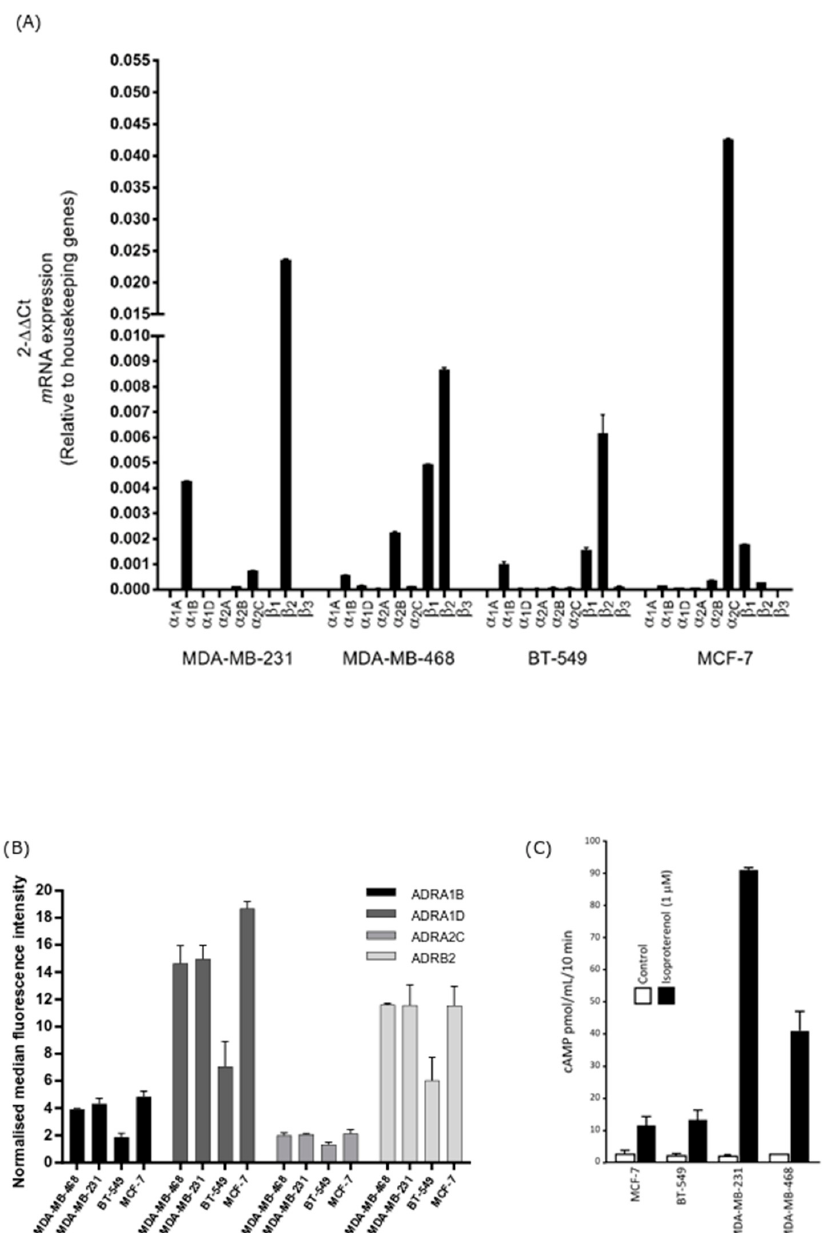
Figure 1. Adrenoceptor (ADR) expression on breast cancer cells and measurement of cAMP (cyclic adenosine monophosphate) levels following adrenergic stimulation. ( A ) Relative expression of ADR mRNA in breast cancer cell lines was quantified by qRT-PCR (quantitative reverse transcription polymerase chain reaction) and relative expression (2 −ΔΔ CT ) was determined by normalisation to housekeeping genes. β 2-adrenoceptor gene expression was strongest in the basal-type cell lines MDA-MB-231 and MDA-MB-468. ( B ) Expression of the adrenoceptors on unpermeabilised breast cancer cells was assessed by measuring median fluorescence intensity (MFI) using flow cytometry. Membranous β 2-adrenoceptor protein expression was highest in the basal-type cell line MDA-MB-468, followed by MDA-MB-231 > MCF-7 > BT-549. ( C ) Isoproterenol ( β -agonist) stimulated cAMP accumulation in breast cancer cell lines. Cells were treated in the presence of IBMX to prevent cAMP degradation. cAMP production was highest in the order MDA-MB-231 > MDA-MB-468 > BT-549 > MCF-7. All assays were performed in triplicate ( n = 3). Results shown are the mean ± standard deviation.